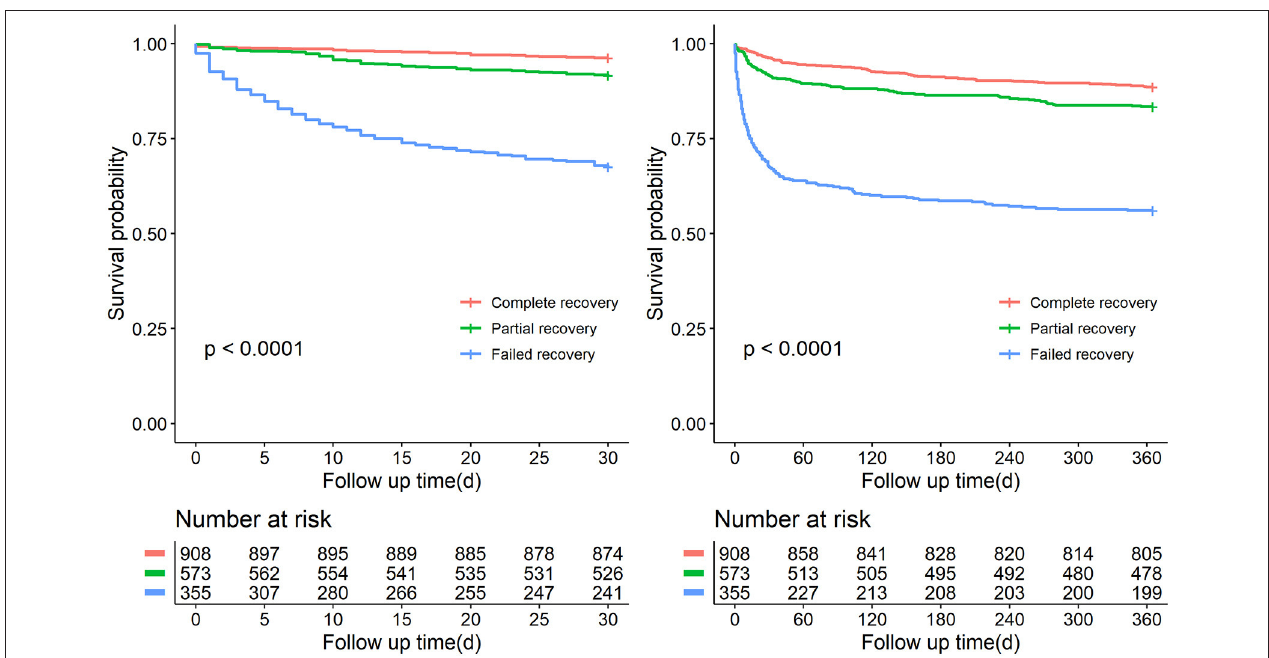
FIGURE 3 | Patient survival probability within 30 days and 1 year of patients at discharge having different renal function